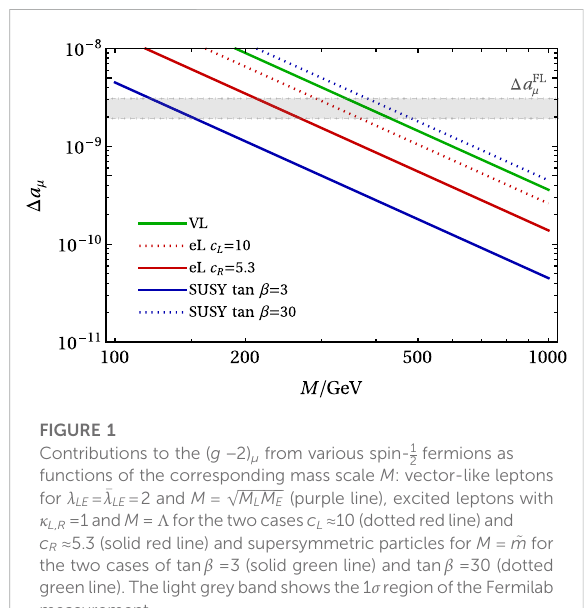
FIGURE 1 fermions as Contributions to the ( g − 2) μ from various spin- 1 2 functions of the corresponding mass scale M : vector-like leptons (cid:1)(cid:1)(cid:1)(cid:1)(cid:1)(cid:1) √ for λ LE (cid:1) (cid:1) λ LE (cid:1) 2 and M (cid:1) M L M E (purple line), excited leptons with Λ forthetwocases c ≈ 10(dottedredline)and κ L , R =1and M = L c R ≈ 5.3 (solid red line) and supersymmetric particles for M (cid:1) ~ m for the two cases of tan β =3 (solid green line) and tan β =30 (dotted greenline).Thelightgreybandshowsthe1 σ regionoftheFermilab